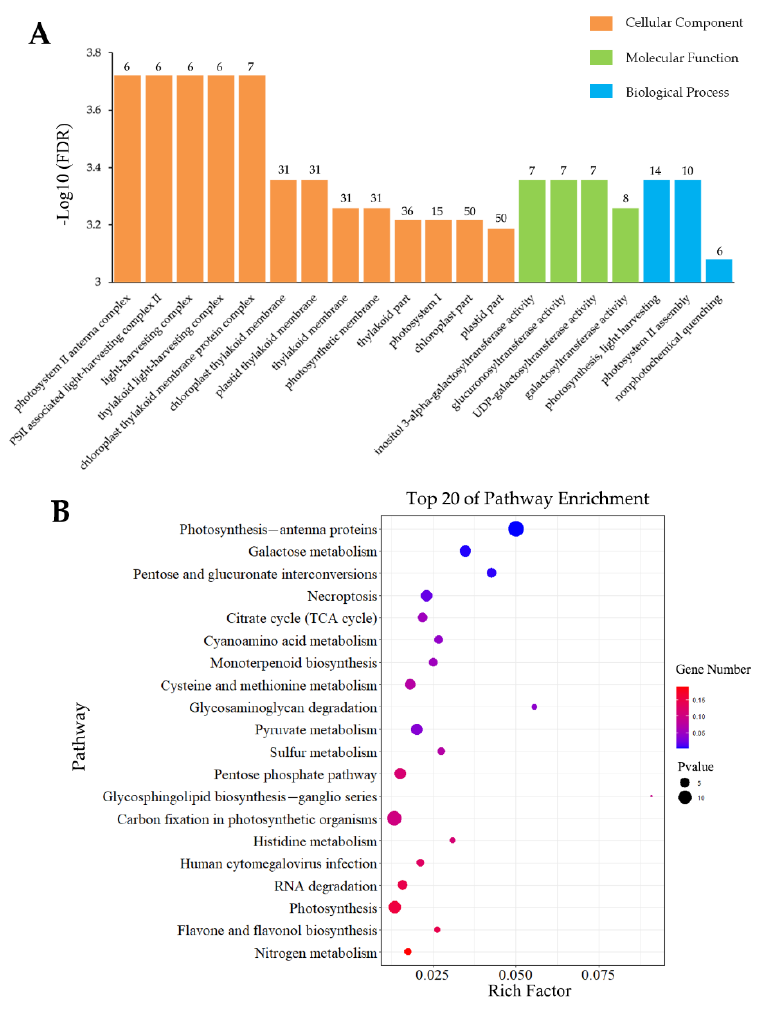
Figure 5. GO ( A ) and KEGG ( B ) analysis of DEGs induced by wounding specificity.